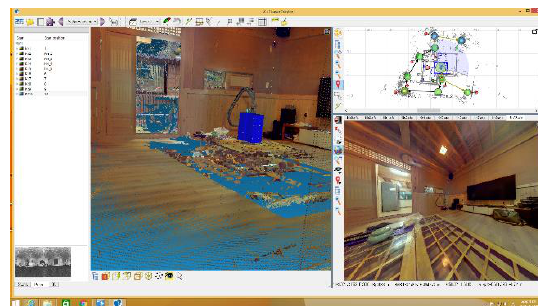
Figure 8. 3D model generated at Station 6 and photo image